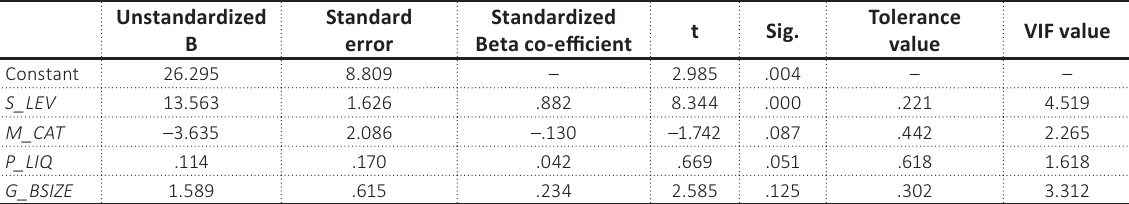
Table 4. Regression